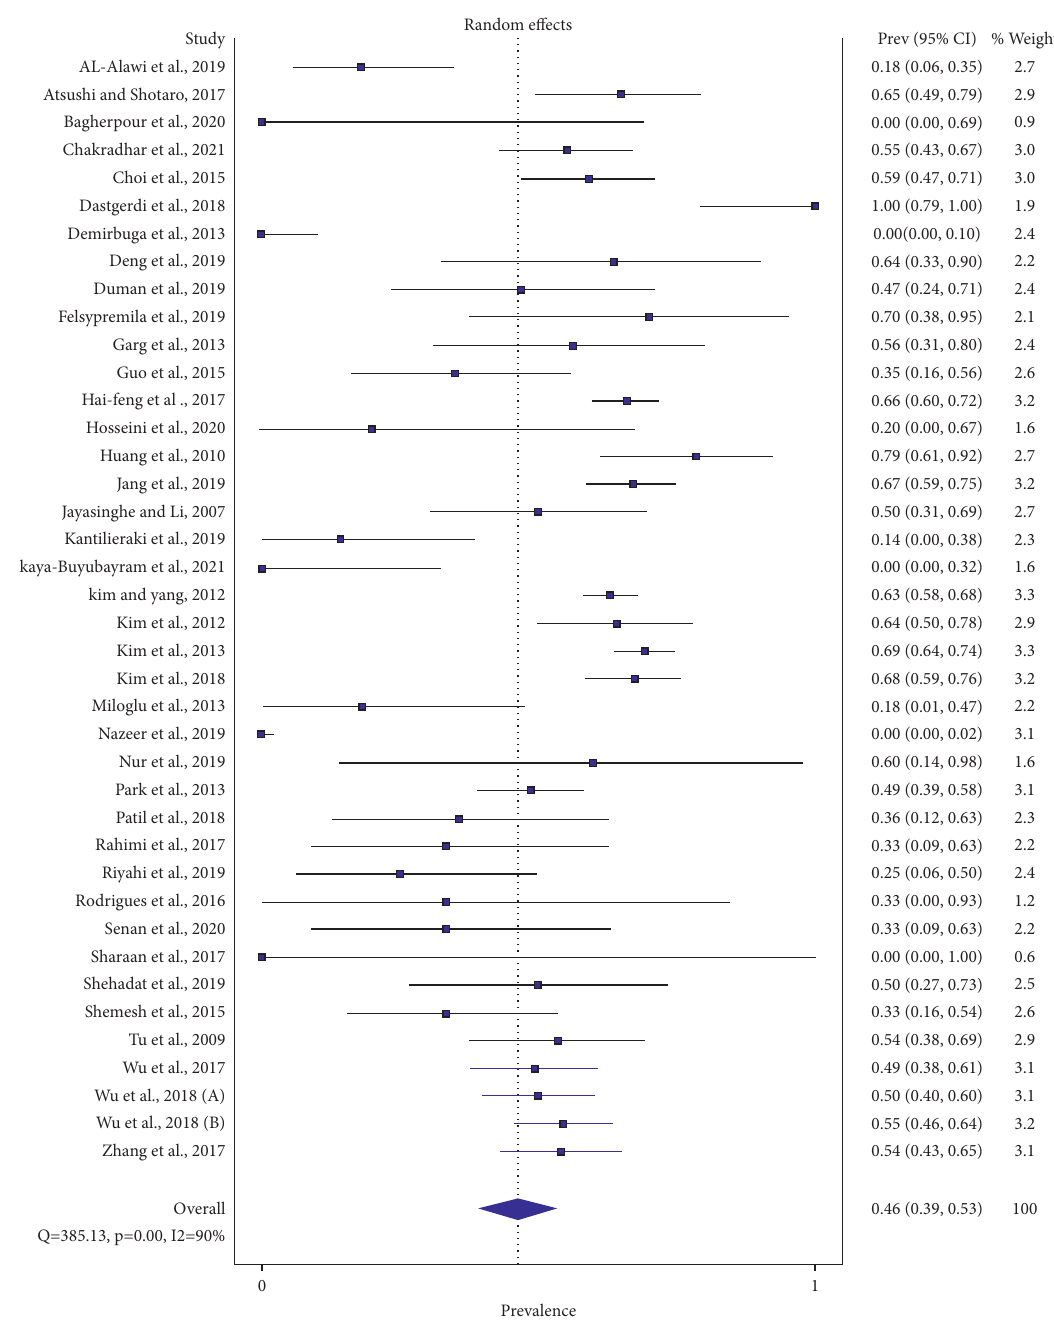
Figure 8: Global patient-level bilateral symmetry of three-rooted